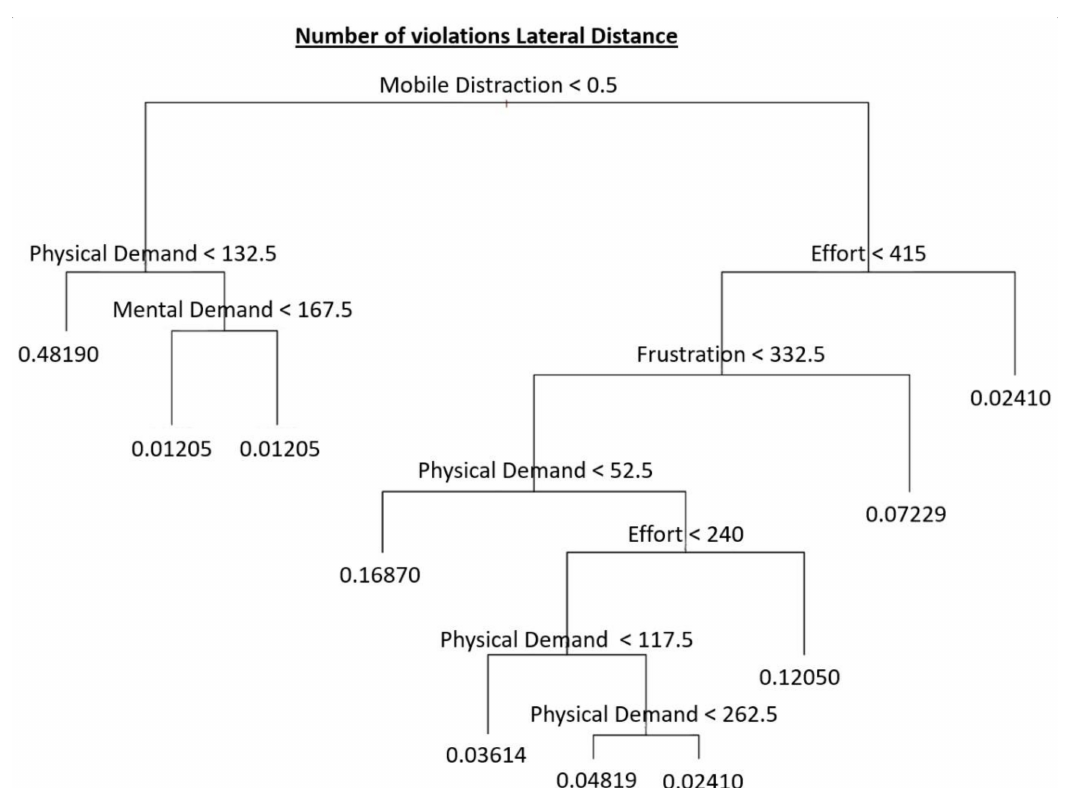
Figure 4. Regression tree related to the number of violations of Lateral